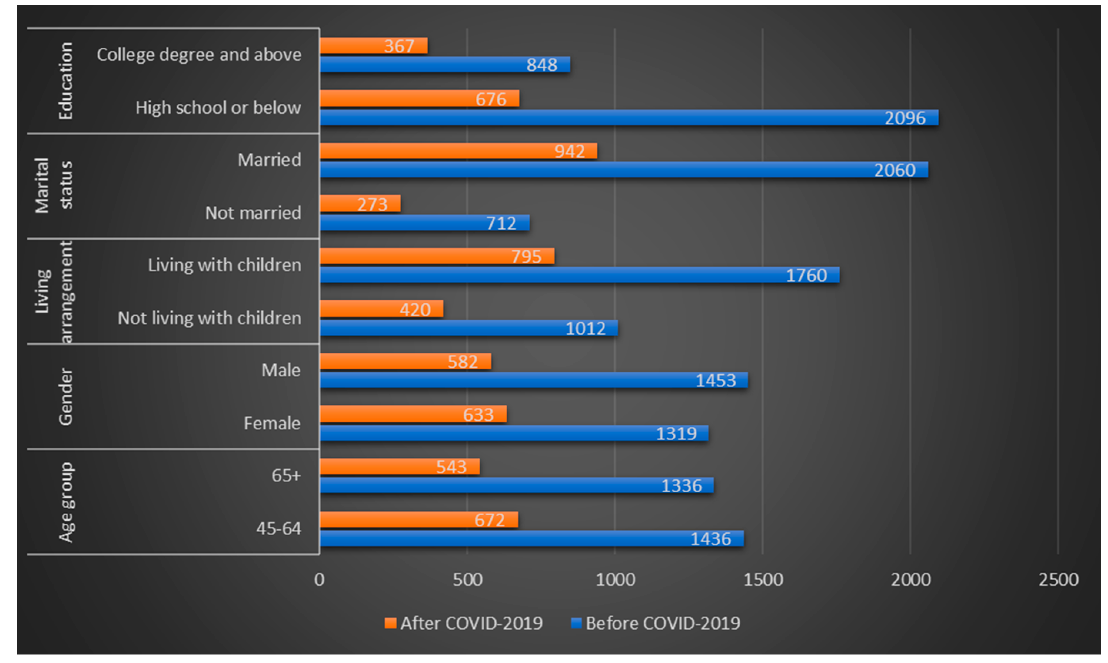
Figure 2. Sample characteristics of the two questionnaires.